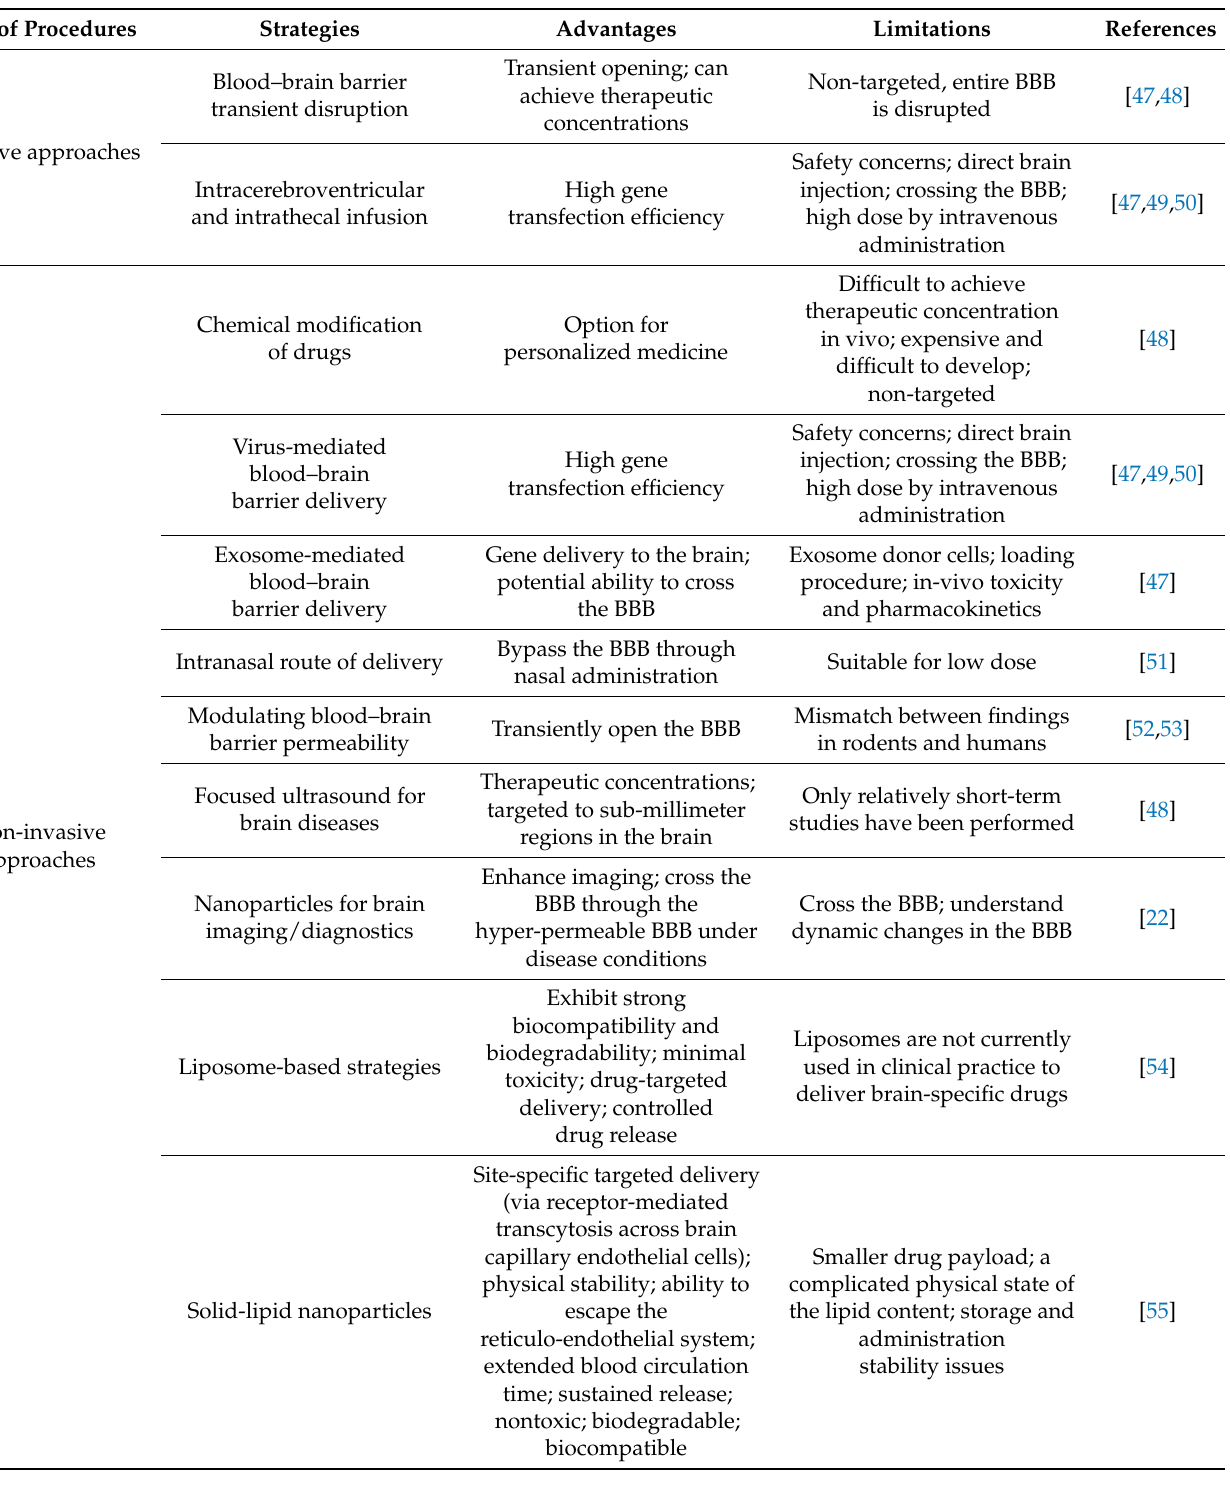
Table 1. Strategies for brain drug